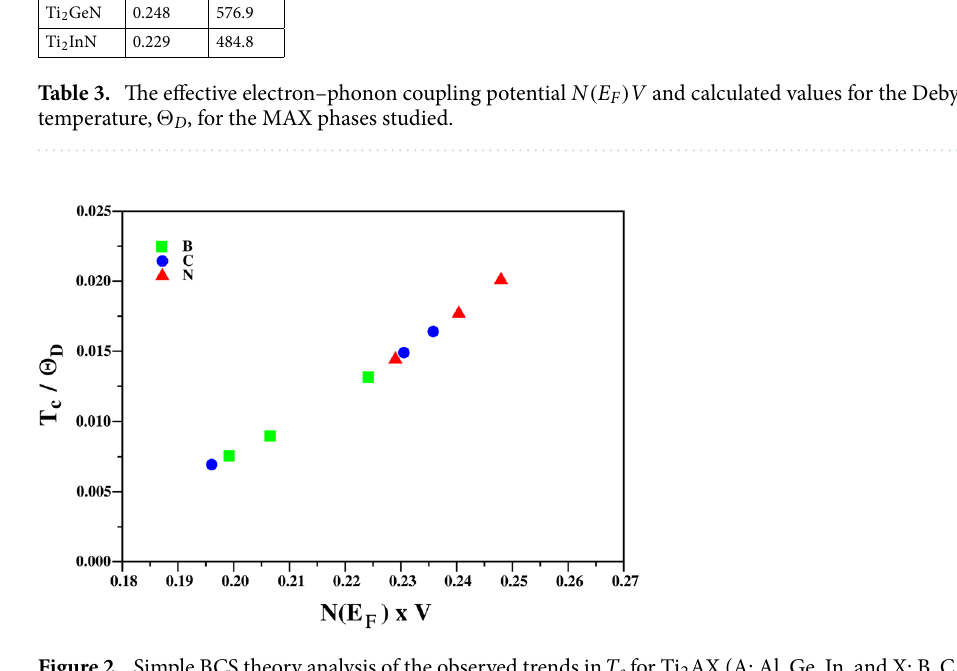
Figure 2. Simple BCS theory analysis of the observed trends in T c for Ti 2 AX (A: Al, Ge, In, and X: B, C, or N).